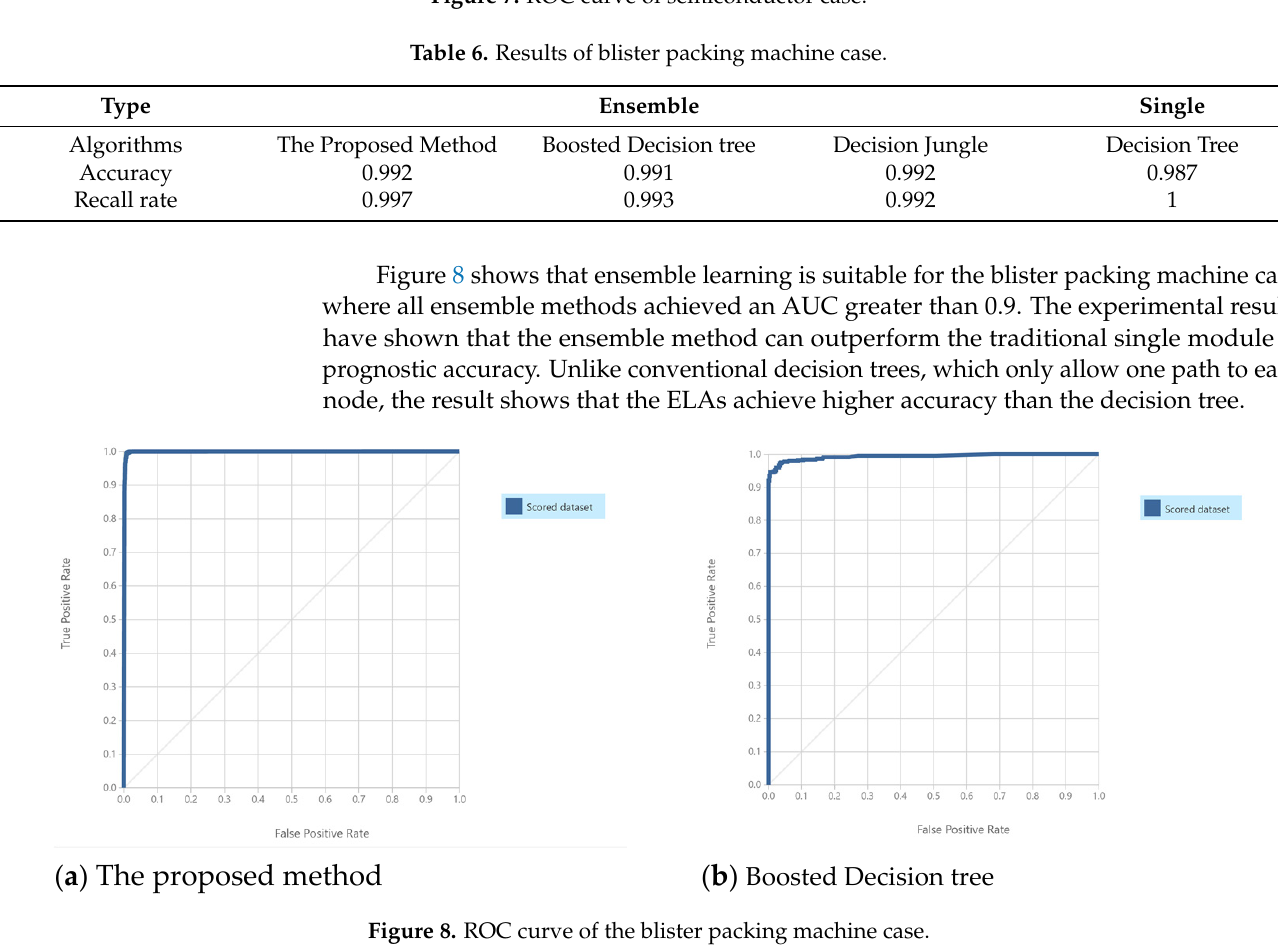
( b ) Boosted Decision tree Figure 8. ROC curve of the blister packing machine case. In summary, the result obtained using the proposed method was compared with that of the boosted decision tree and decision tree. Furthermore, the obtained result indicates